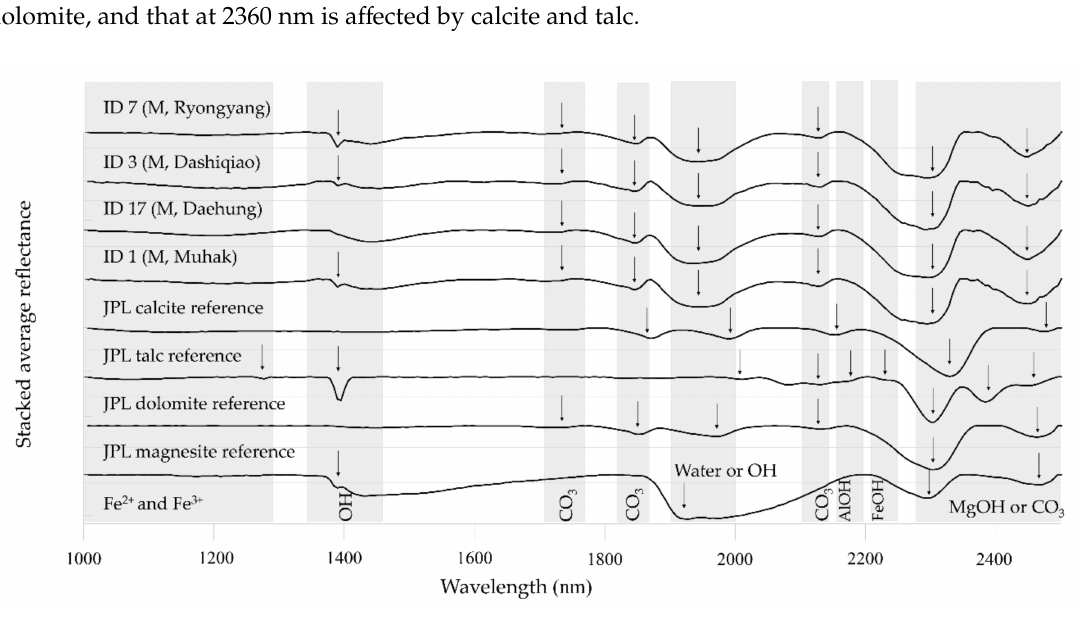
Figure 1. The average hull quotient corrected reflectance spectra of magnesite sample pixels compared with those from library